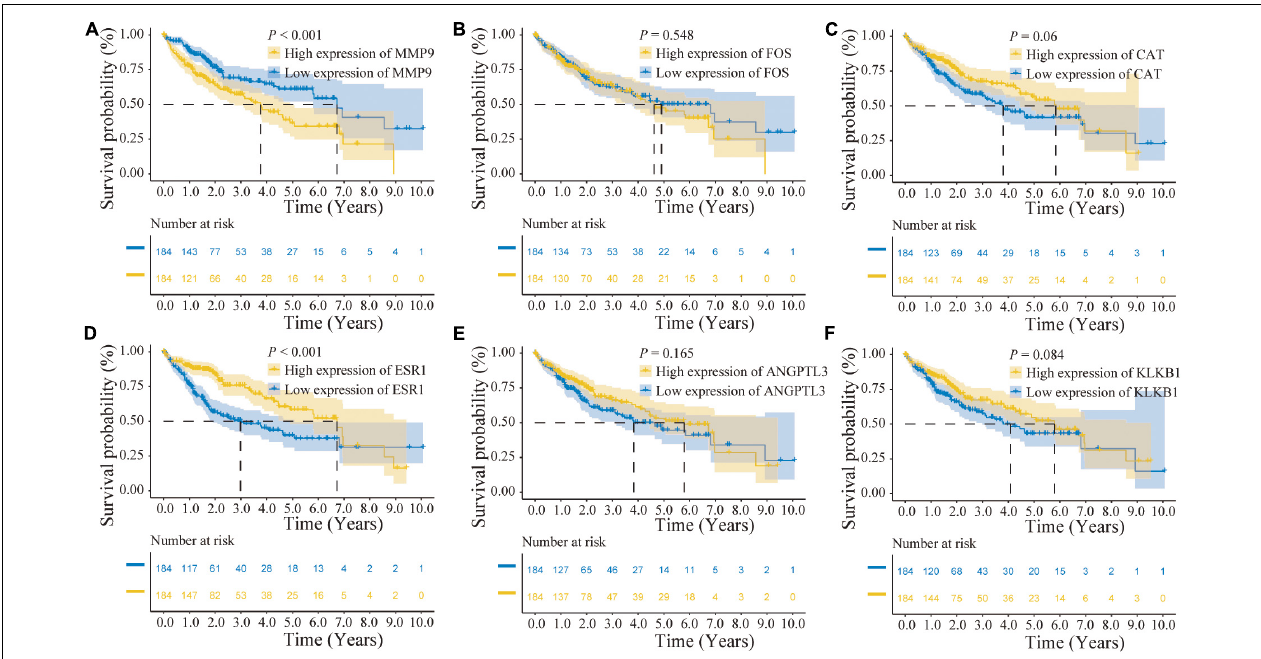
FIGURE 6 | Prognostic analysis of the characteristic immune-related genes (IRGs) in the cancer genome atlas (TCGA) database. (A) High MMP9 gene expression suggested poor patient prognosis (log-rank P < 0.001). (B,C) The expression levels of the FOS and CAT genes were not significantly correlated with the prognosis of hepatocellular carcinoma (HCC) patients. (D) Low ESR1 gene expression suggested poor patient prognosis (log-rank P < 0.001). (E,F) The expression levels of the ANGPTL3 and KLKB1 genes were not significantly correlated with the prognosis of HCC